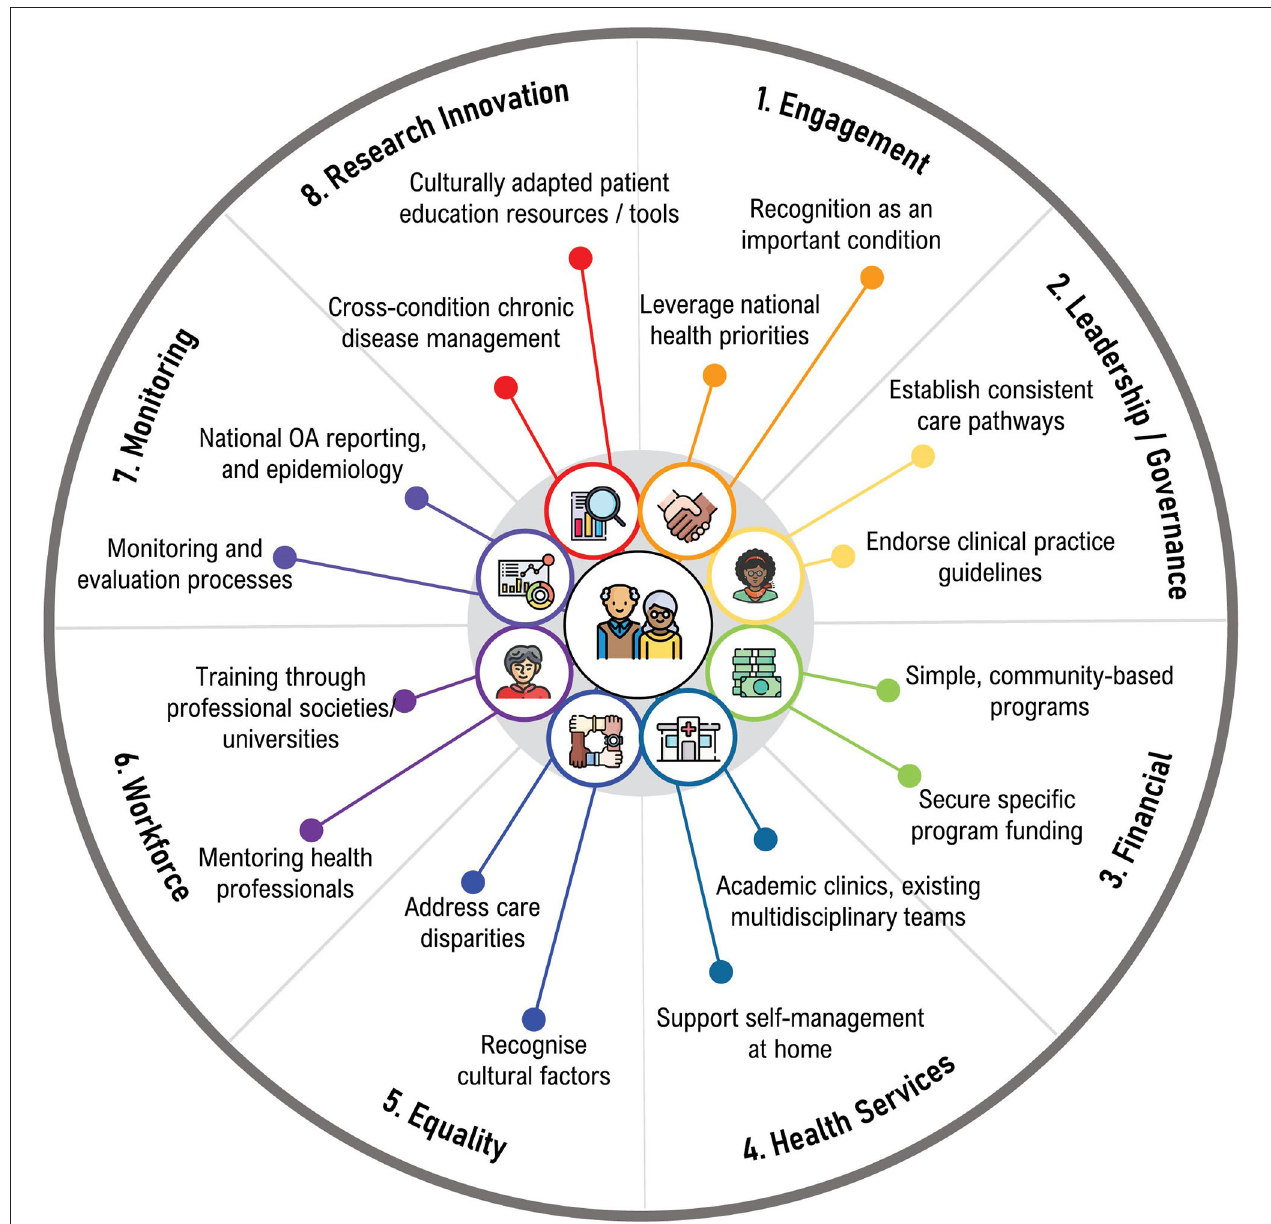
FIGURE 2 | Considerations for implementation of best-evidence osteoarthritis care in Lowand Middle-Income